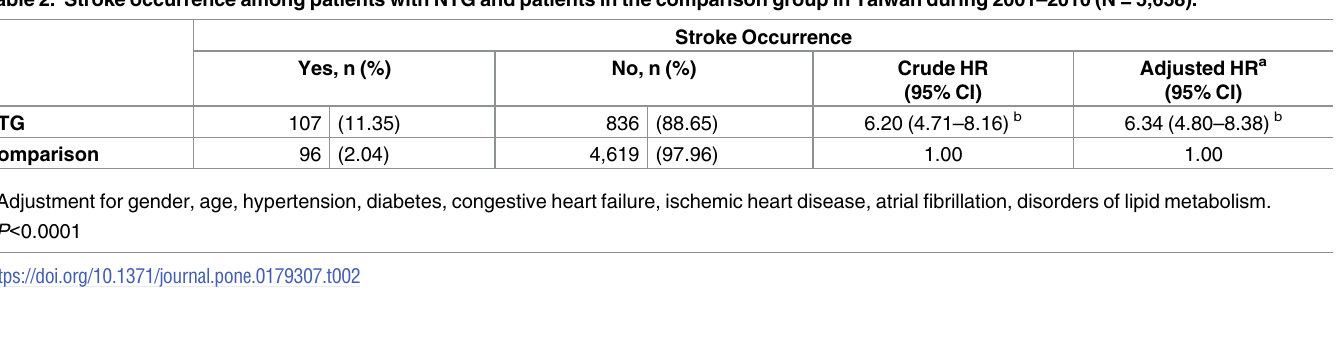
Table 2. Stroke occurrence among patients with NTG and patients in the comparison group in Taiwan during 2001–2010 (N =